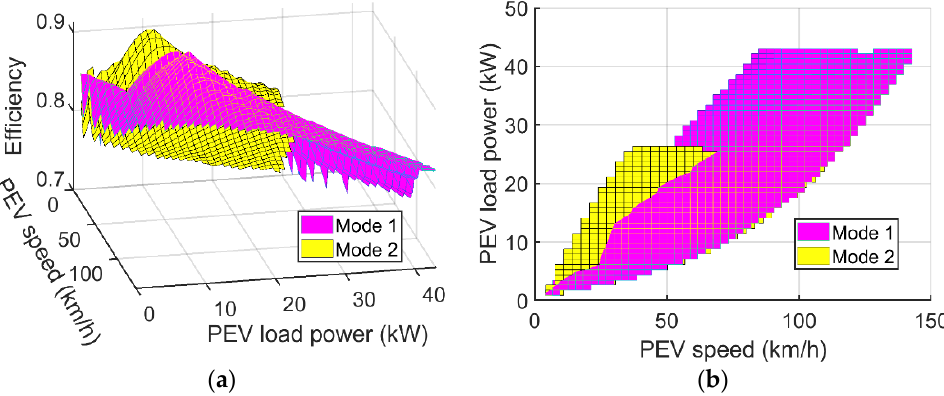
Figure 10. Characteristics of optimized PEV. ( a ) MAP of efficiency characteristic; ( b ) working area. Table 2. Parameter values of N-DMCDS before and after optimization.